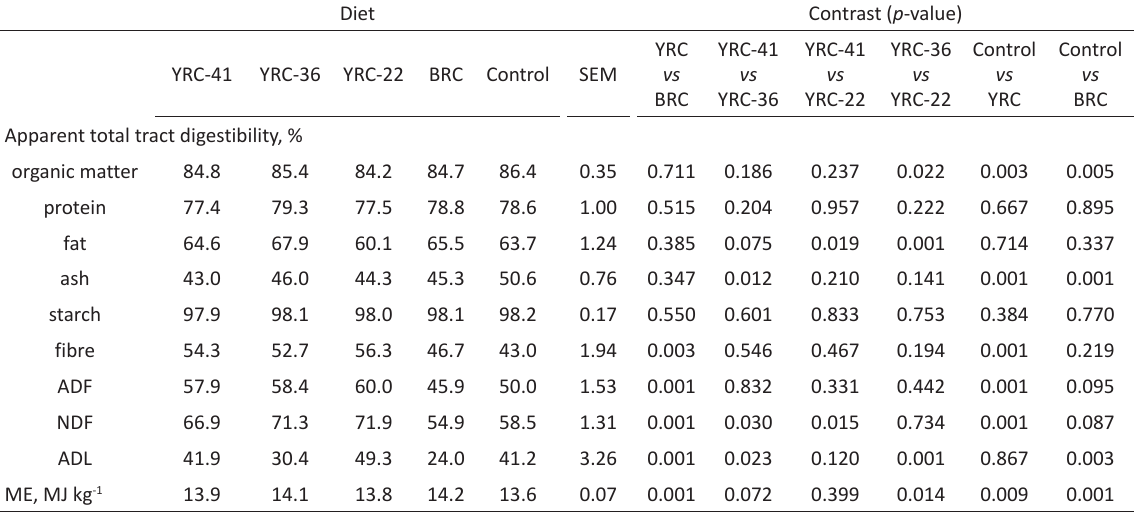
Table 5. Apparent total tract digestibility of nutrients and fibre fractions (%) and metabolisable energy content (ME, MJ kg -1 ) in diets containing rapeseed cake or the control diet containing soyabean oil meal (Experiment 2) Diet